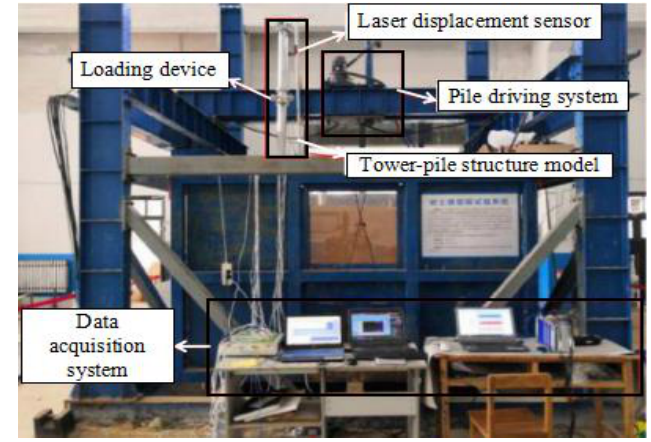
Figure 3. Model test. Figure 3. Model